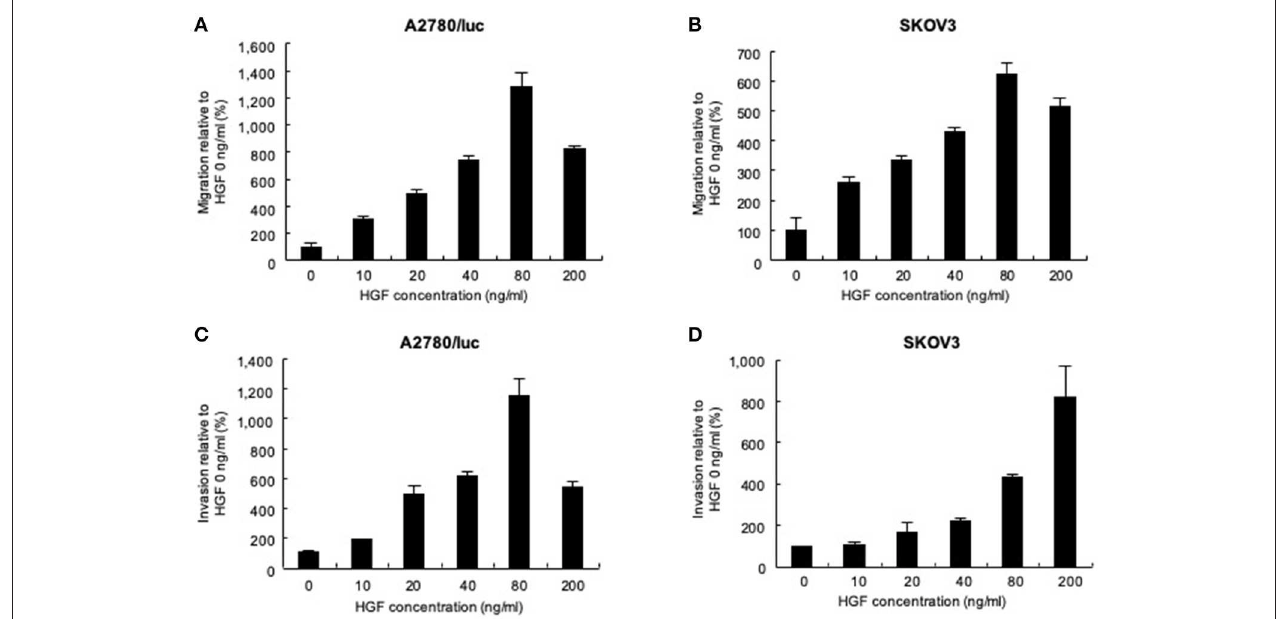
FIGURE 1 | Effect of recombinant human hepatocyte growth factor (HGF) on the migration and invasion of ovarian cancer cells. Migration assays: (A) 3 × 10 5 A2780/luc and (B) 1 × 10 5 SKOV3 cells were seeded in upper chambers while the lower chambers contained 0, 10, 20, 40, 80, or 200ng/mL HGF. After 48 or 8h culture (A2780/luc or SKOV3 cells, respectively), migrated cells were observed using light microscopy. Invasion assay: (C) 2 × 10 5 A2780/luc and (D) 0.5 × 10 5 SKOV3 cells were seeded onto Matrigel-coated plates while lower chambers contained 0, 10, 20, 40, 80, or 200ng/mL HGF. After 72 or 48h culture (A2780/luc or SKOV3 cells, respectively), infiltrated cells were observed using light microscopy.